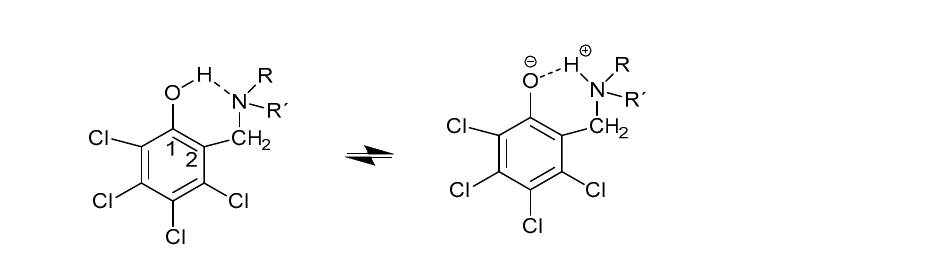
Figure 17. Tautomeric equilibrium of the Mannich base based on 2-hydroxy-3,4,5,6-tetrachlorobenzene.